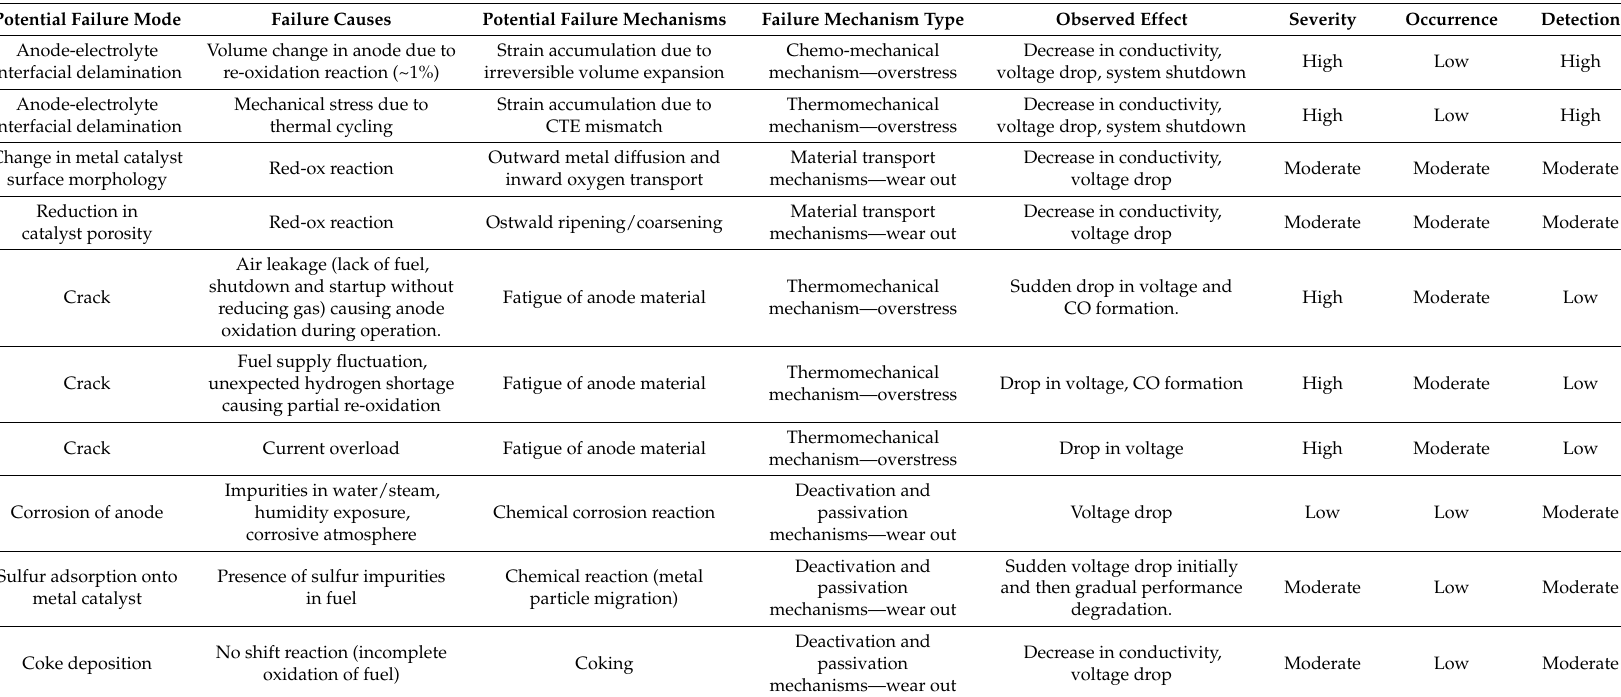
Table 5. Failure modes, mechanisms, effects, and criticality analysis (FMMECA) for ceramic